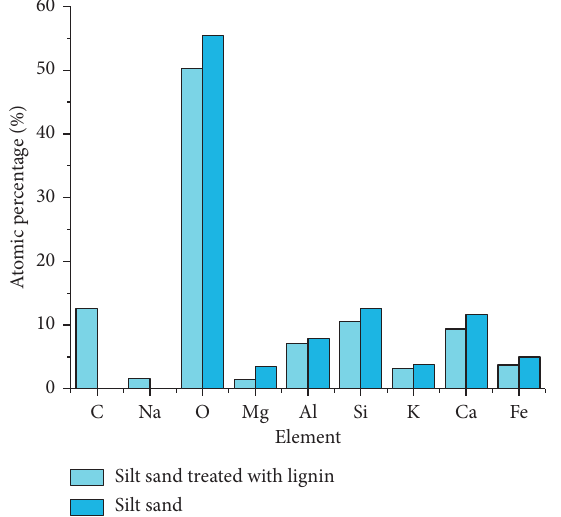
Figure 15: Infrared spectrum of silt sand and silt sand treated with